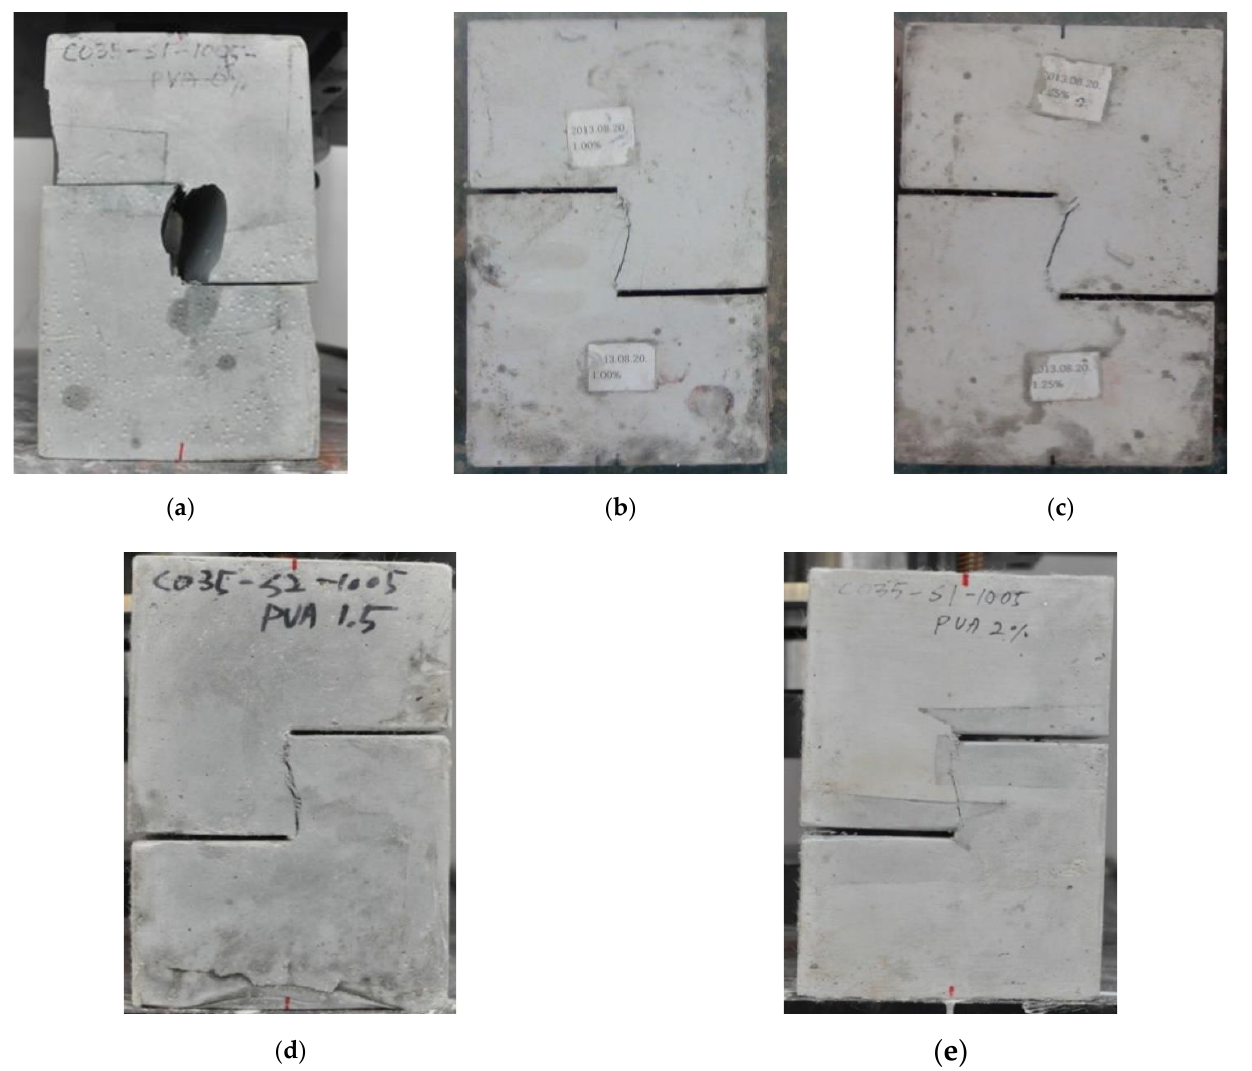
Figure 12. Failure of shear specimens: ( a ) ASFC000 (PVA 0.00 vol.%); ( b ) ASFC100 (PVA 1.00 vol.%); ( c ) ASFC125 (PVA 1.25 vol.%); ( d ) ASFC150 (PVA 1.50 vol.%); ( e ) ASFC200 (PVA 2.00 vol.%). Table 8. Results of shear strength test.